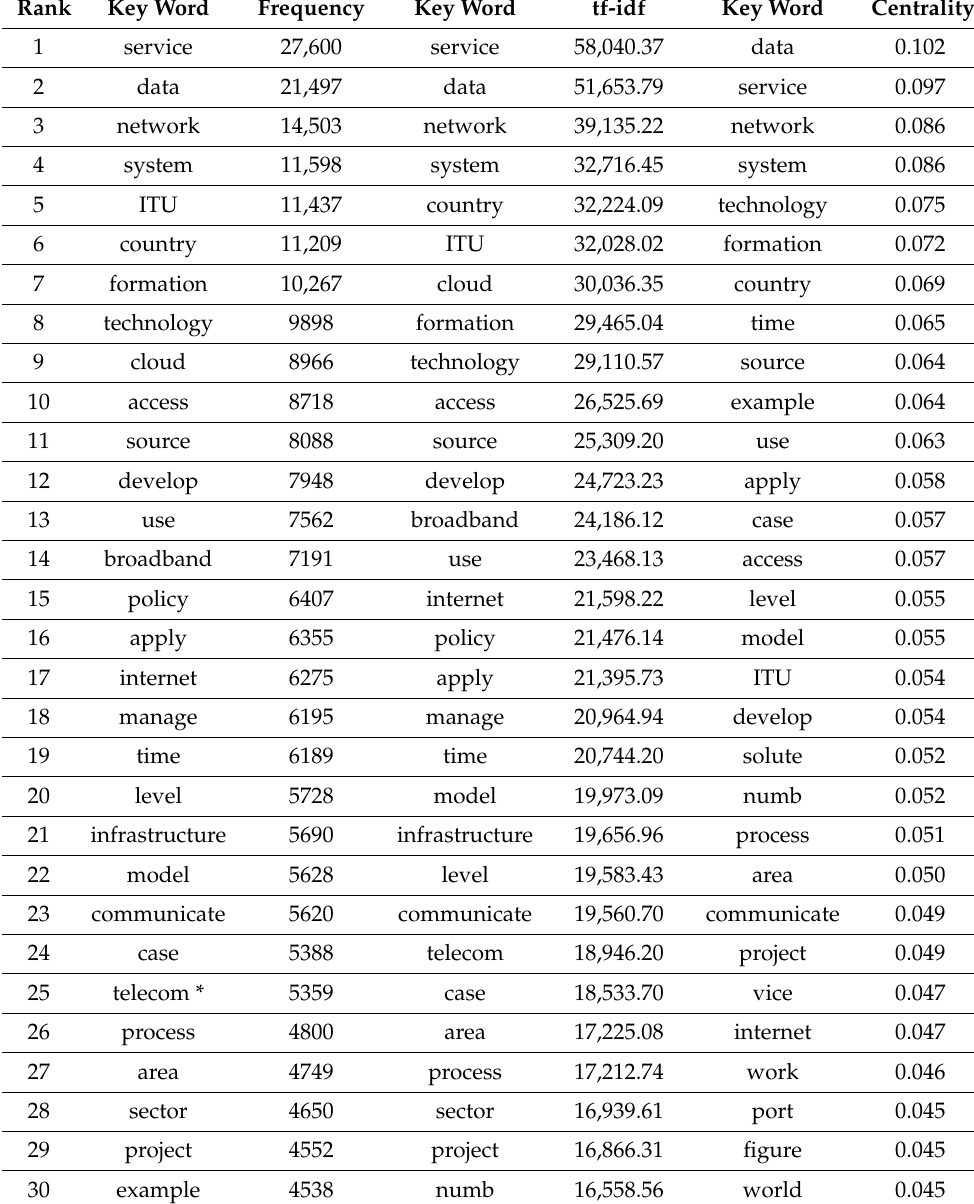
Table 2. Text mining analysis